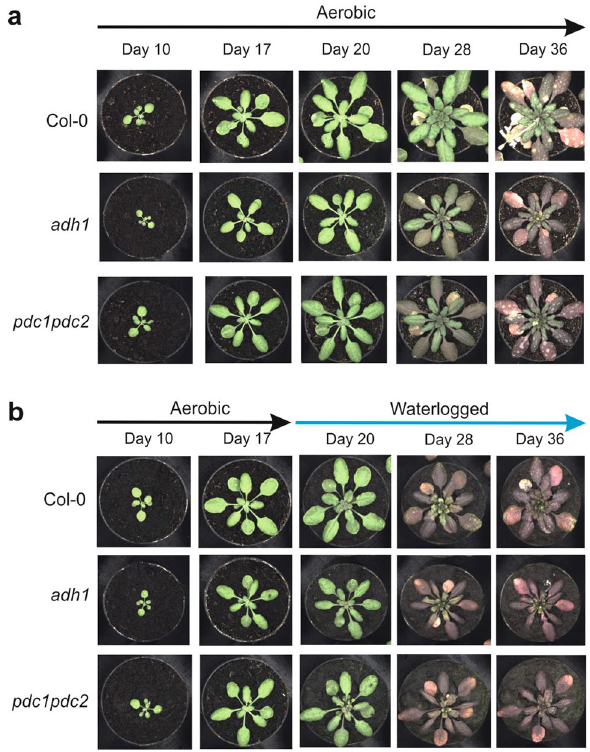
Figure 3. Effect of waterlogging on the phenotype of Arabidopsis plants. Plants were grown under aerobic conditions for 17 days and then transferred to waterlogging conditions. Waterlogging treatments were performed with plants having all the root system under water, but with the petioles and leaves above the water level. ( a ) Plants grown under aerobic conditions for 36 days. ( b ) Plants grown under aerobic conditions for 17 days and transferred to waterlogging conditions for up to 36